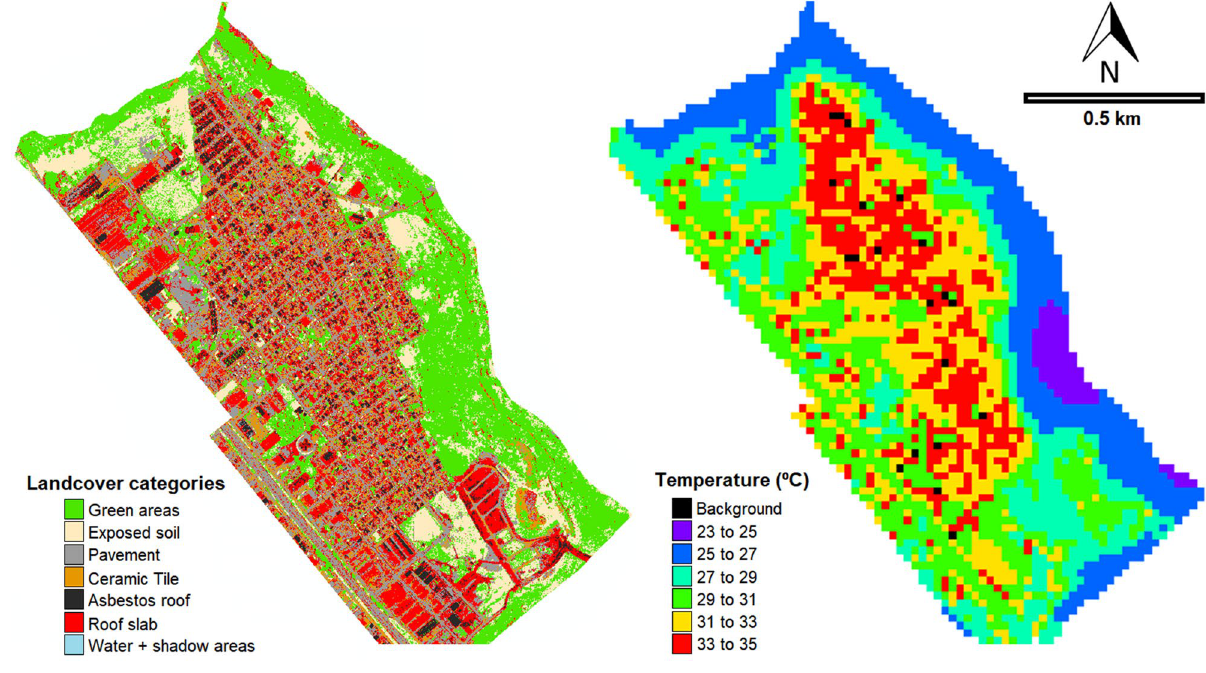
Figure 2. Vila Toninho neighborhood. Left: WorldView 3 image showing seven different landcover categories. Right: Landsat 8 TIRS showing surface